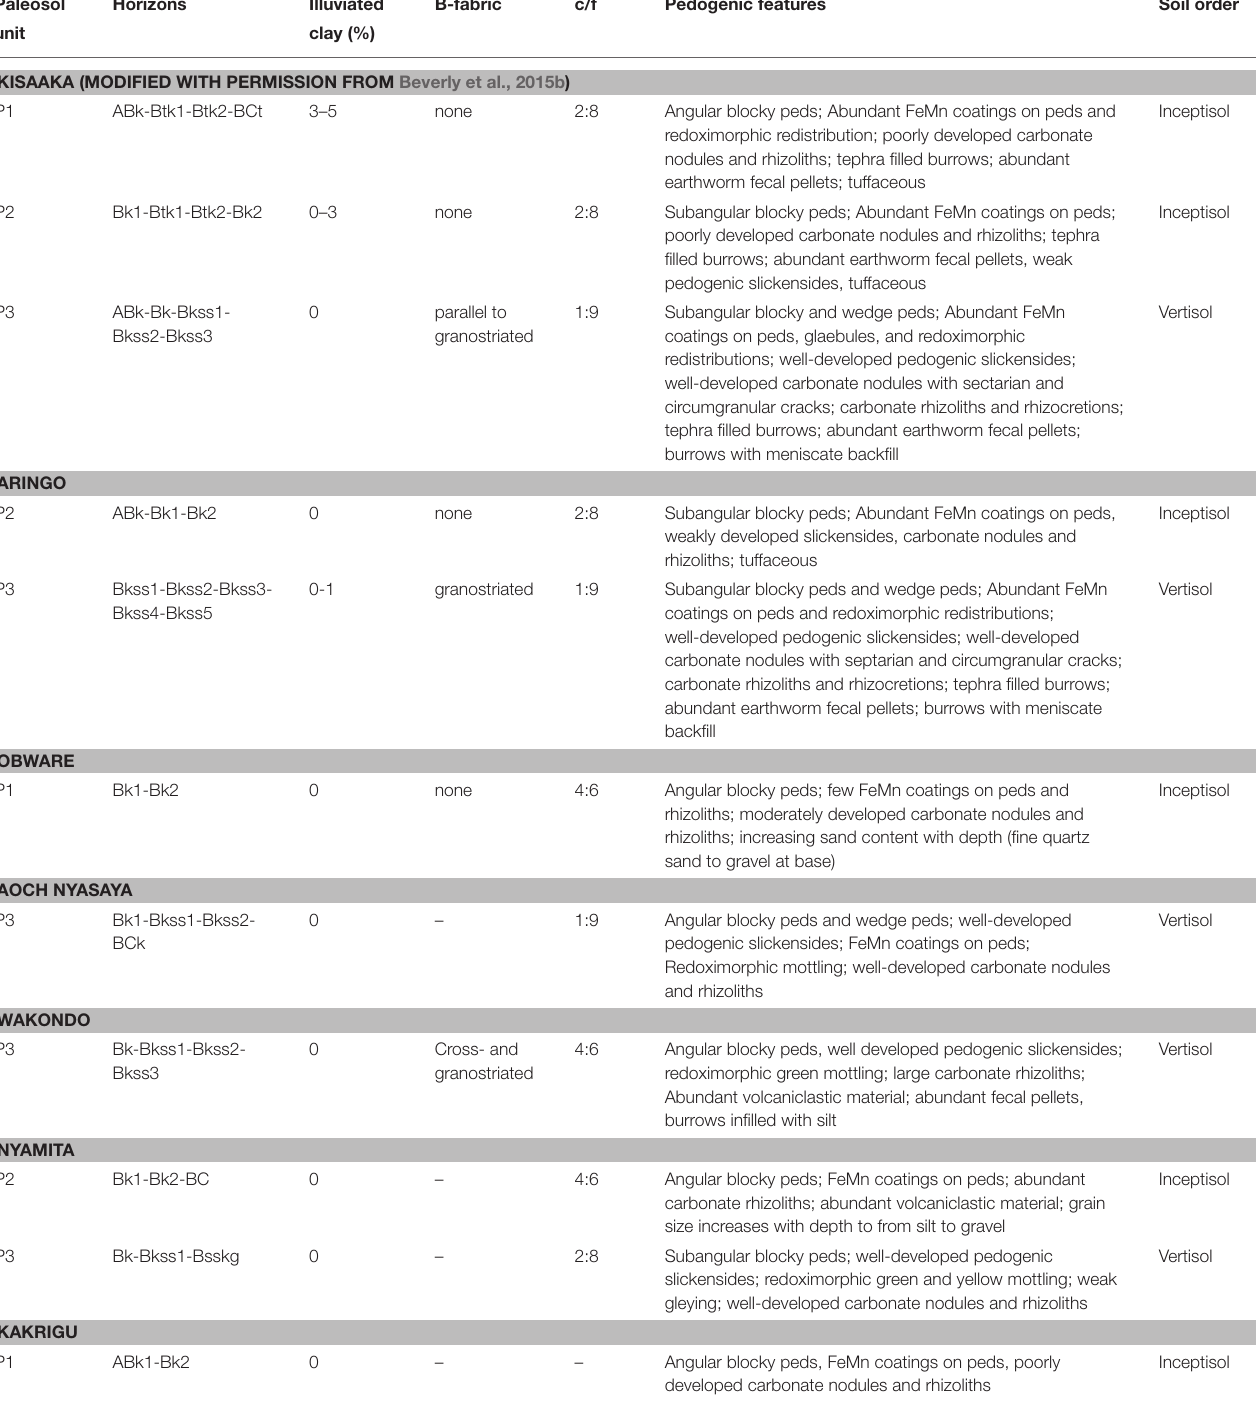
TABLE 2 | Summary of field and micromorphological descriptions of type section paleosols from each site. Paleosol